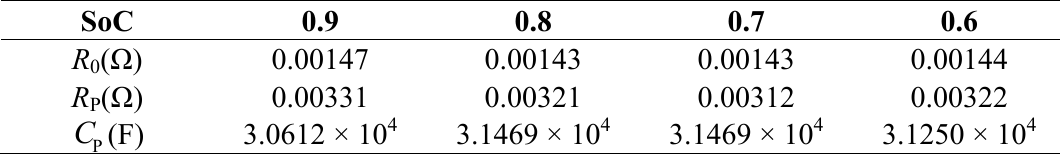
Table 1. The identified model parameters.